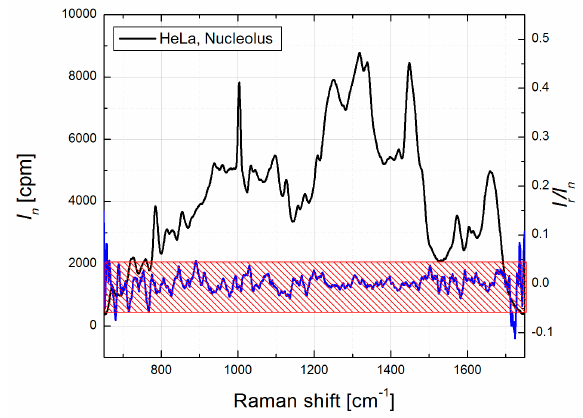
Figure 2. Mean Raman spectrum of HeLa nucleolus, collected from 8 single cells (black curve, left Y -axis) and ratio I n /I r , (blue curve, right Y -axis), where I n and I r are corresponding intensities of mean nucleolus and residual spectra. Red patterned box shows ±5% margins at the left Y axis.